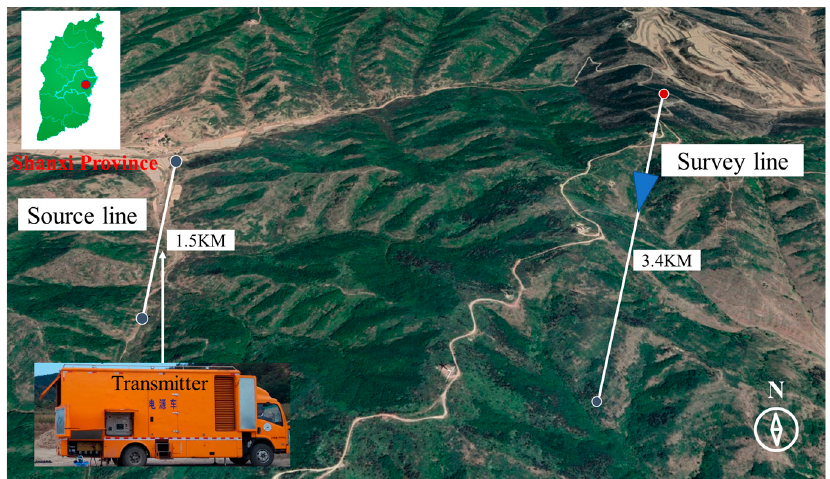
Figure 10. Location of the fi eld experiment.